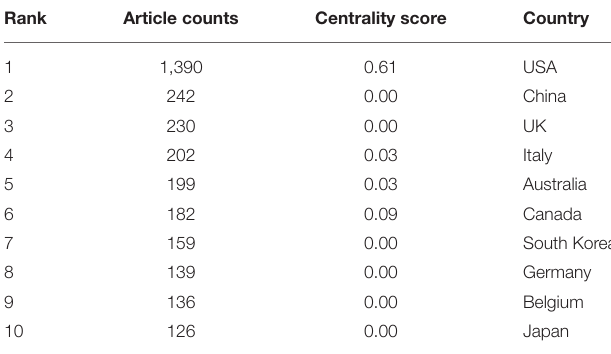
TABLE 1 | Ranking of top-10 countries that have published the most article on CRS-treatment research from 2001 to 2020.